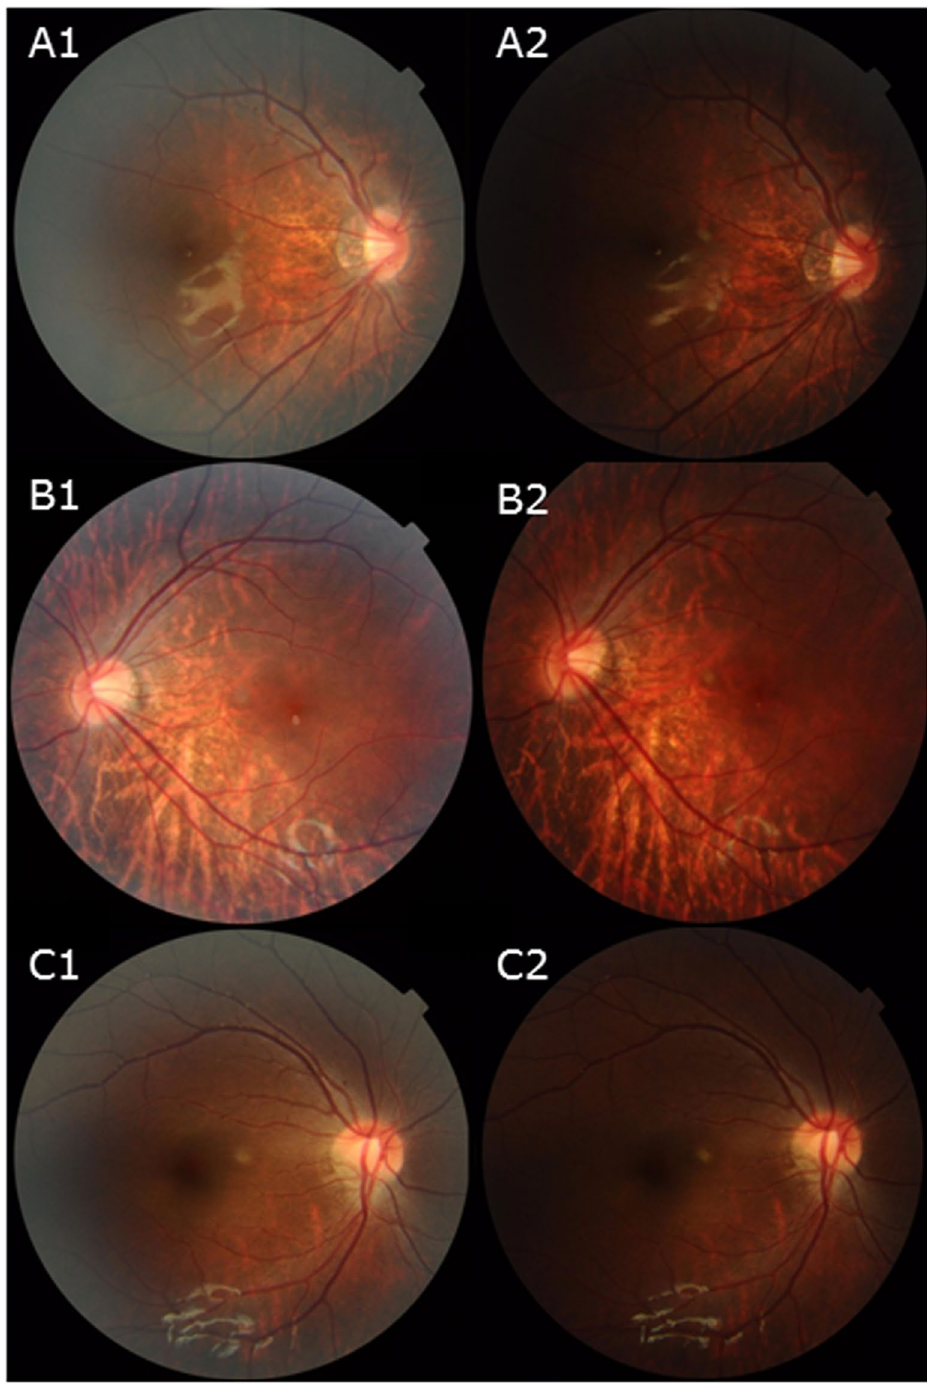
Figure 7. A serial follow up of disc photographs of children. ( A1–2) . Disc photographs of a 3 year old male subject who was followed-up for 2 years. ( B1–2) . Disc photographs of a 5 year old female subject who was followed-up for a year. ( C1–2) . Disc photographs of an 8 year old female subject who was followed-up for 4 years. No specific change of the ONH was evident in all